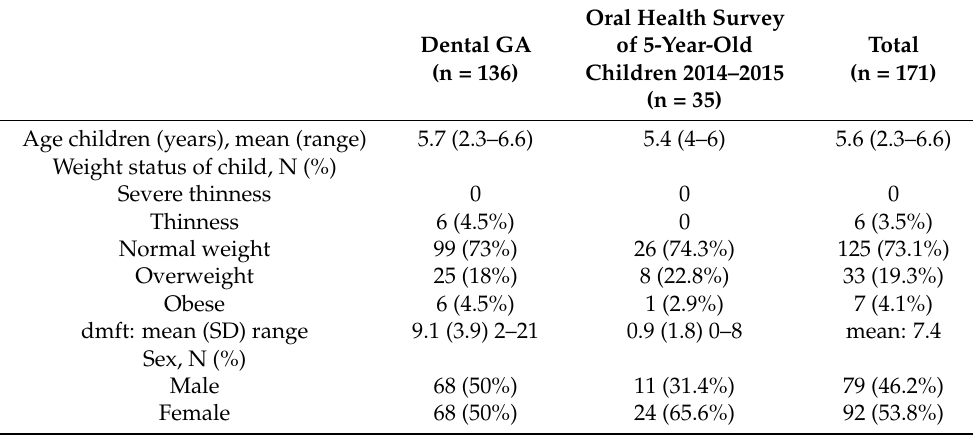
Table 2. Demographic characteristics of child participants.